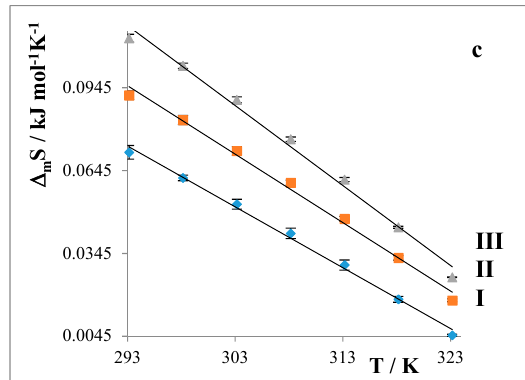
Figure 4. Temperature dependencies of thermodynamic parameters of micellization Δ m G ( a ); Δ m H ( b ); and Δ m S ( c ); surfactants I : C12, II : C14, and III : C16.